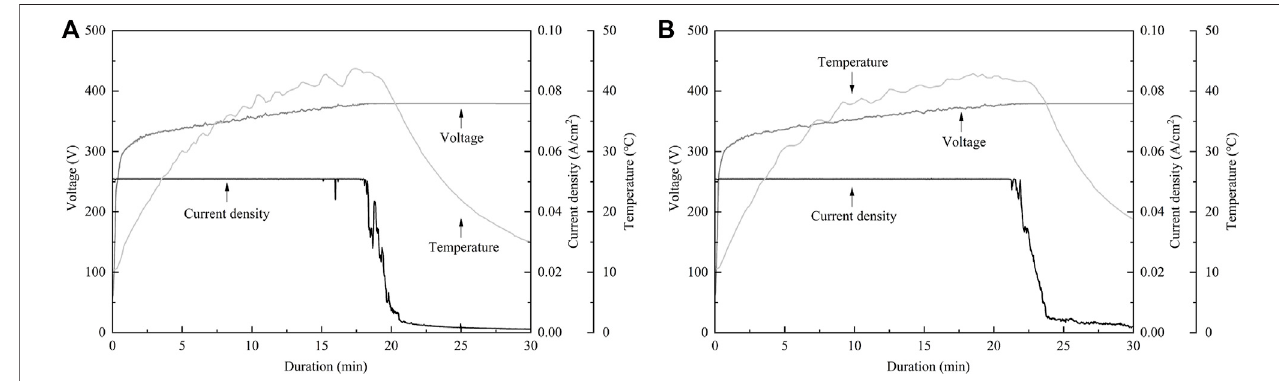
FIGURE A2 | The electrochemical behavior monitored by the electrolysis Curve. (A) The electrolysis curve in anodic oxide with H 2 O 2 , (B) The electrolysis curve in anodic oxide without H 2 O 2 . The sample size is n = 1 in each